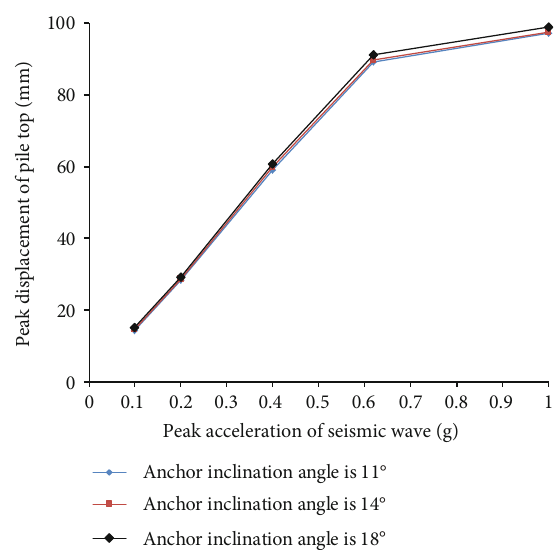
Figure 5: Peak displacement of the pile top under di ff erent working